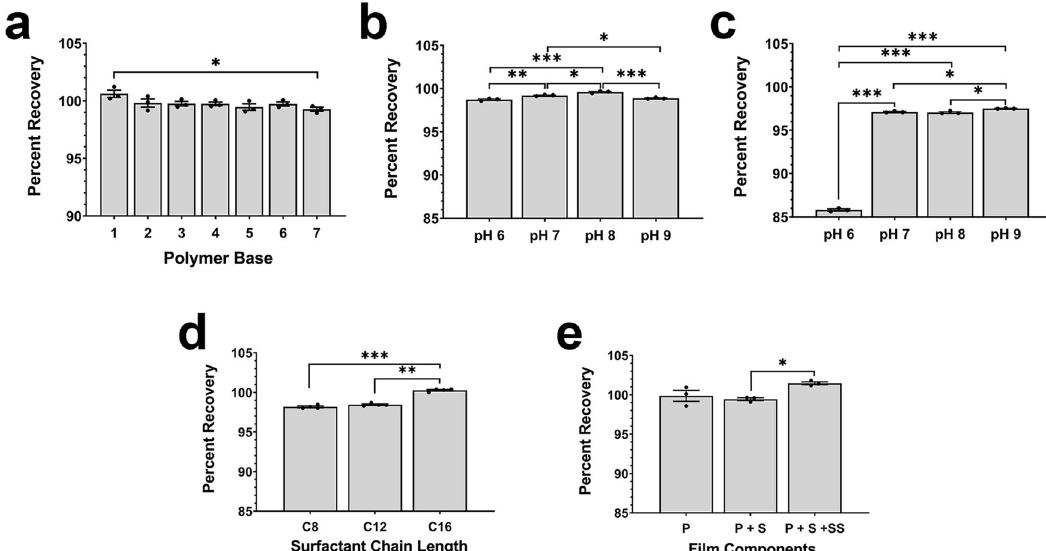
Fig. 2 pH and fi lm components impact recovery of a live vector from fi lm matrix. a Polymer base compositions with decreasing viscosities (1 highest,